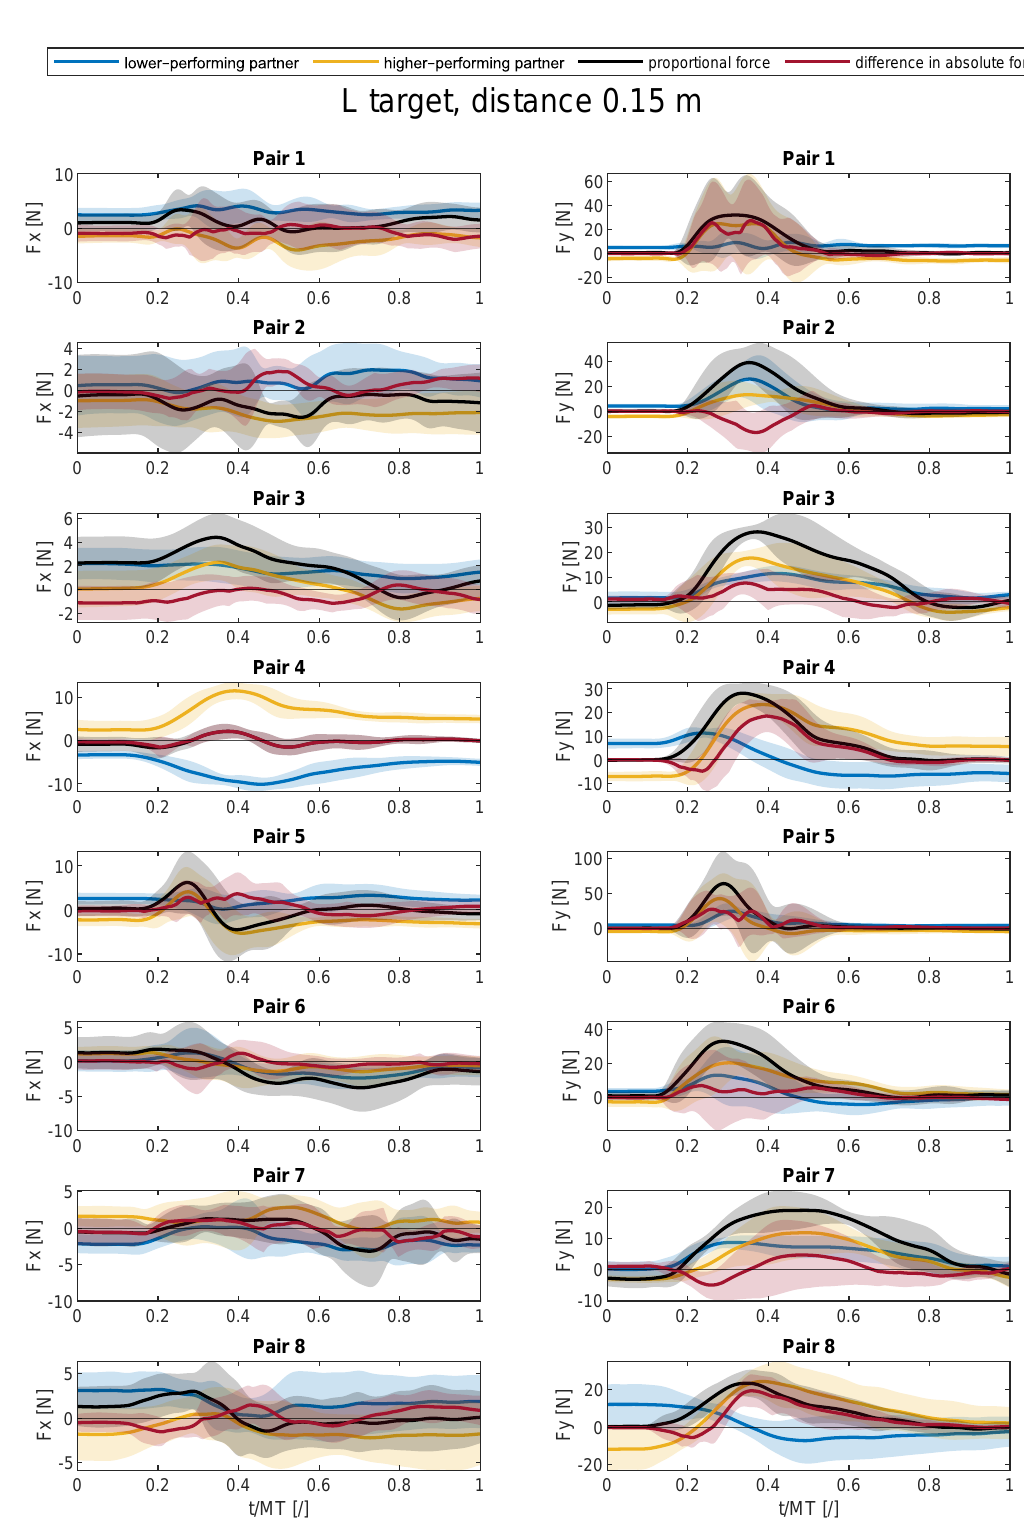
Figure A8. Average force trajectories with standard deviation (shaded area) in x- and y-direction in collaborative task for the large target at the distance of 0.15